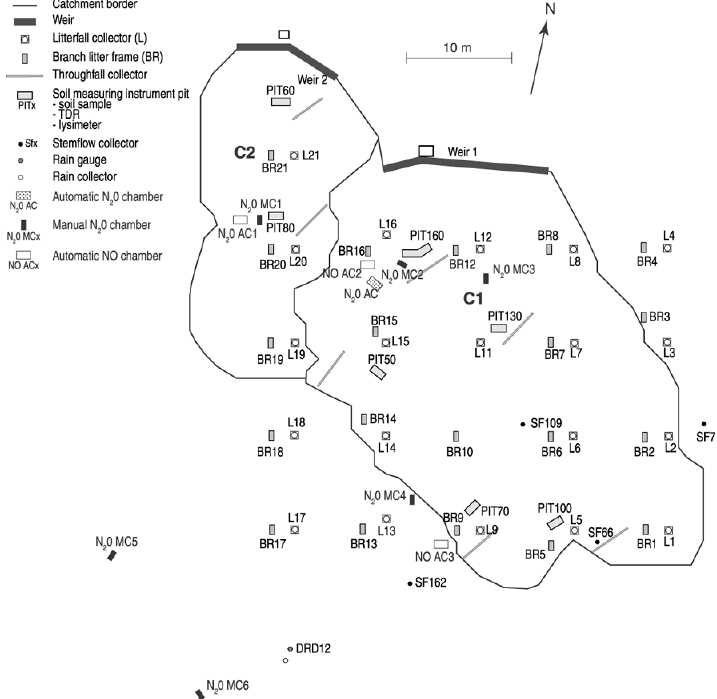
Fig. 1. Map of the measurement site indicating the sampling design for measuring nitrogen fluxes in precipitation, throughfall, stemflow, litter fall, drainage flow, NO- and N 2 O-emissions and nitrogen pools in the soil water. The two catchment areas (C1, C2) are marked on the map with a line, and the drainage flow is directed to the two weirs on top of the map. The height and the diameter at 1.3m of every tree in the catchment areas were measured for biomass